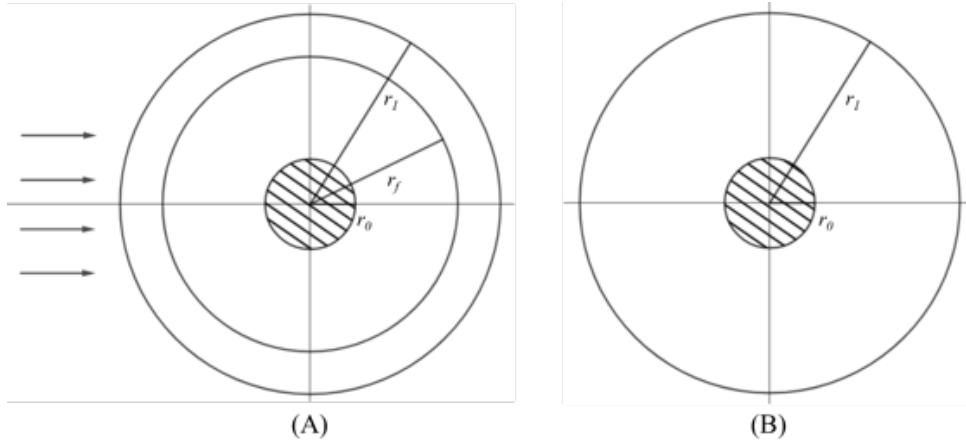
Figure 2. Droplet model of film theory under convective environments: ( A ) Stage 1; ( B ) Stage 2.